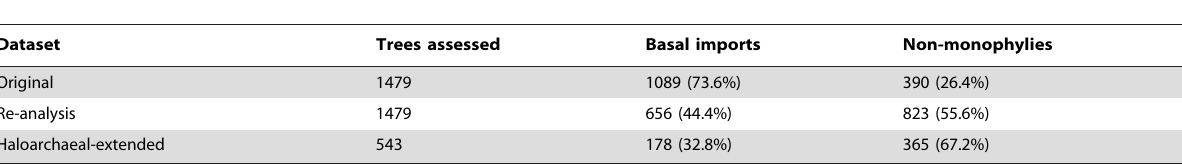
Table 1. Number of inferred basal bacterial imports decreases with added